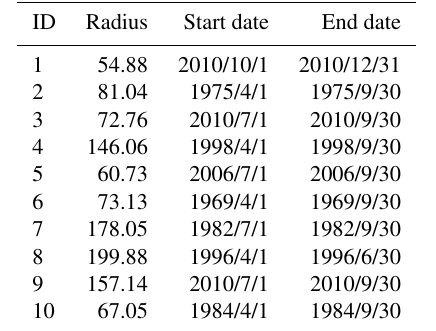
Table 3. Temporal duration of the first 10 clusters of flash flood disasters detected via the monthly model ( R max = 200km, T max = 1 year, T agg = 3 months).